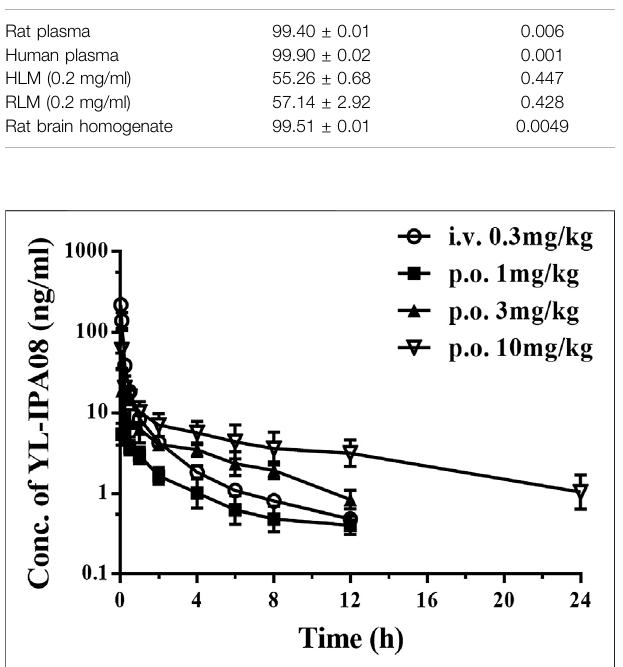
TABLE 3 | Protein bindings (%) and unbound fractions of YL-IPA08 in different sorts of biomatrices (n (cid:2) 3). Biomatrices